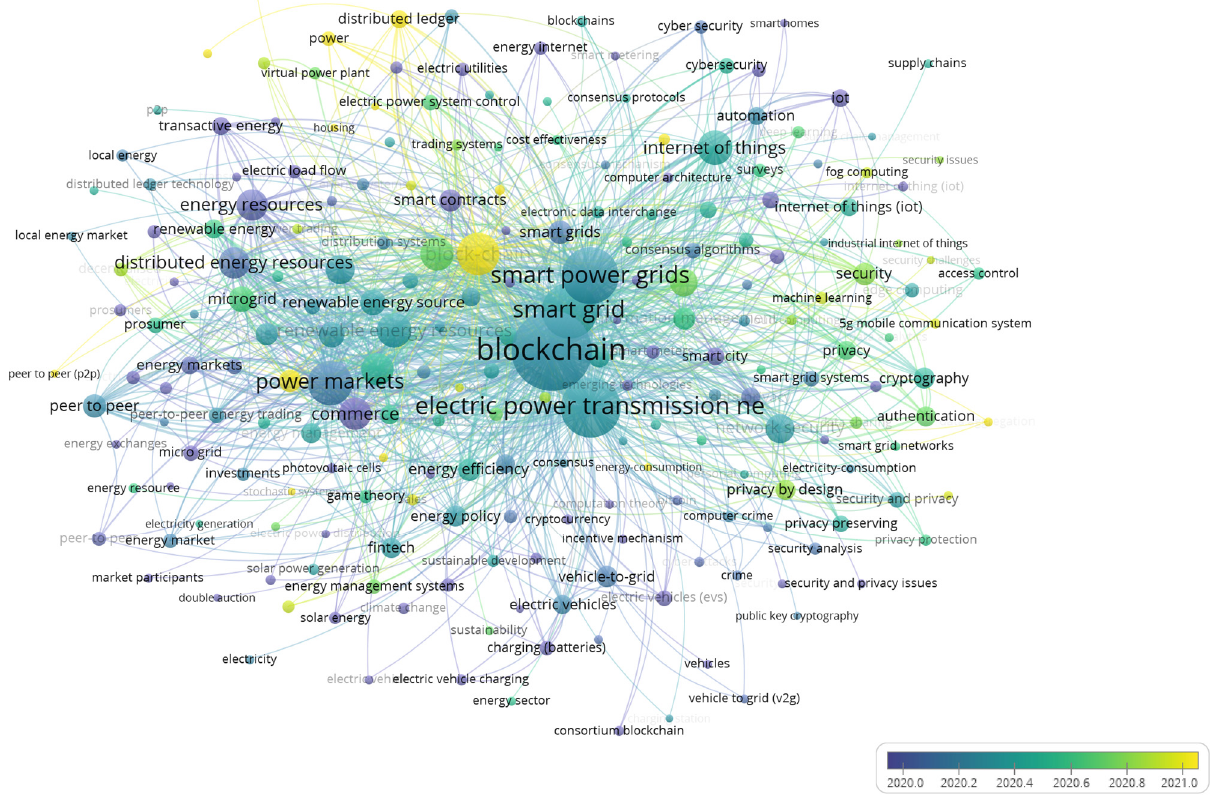
Figure A2. Keyword co-occurrence analysis (using VOS Viewer)—a zoomed-in view.